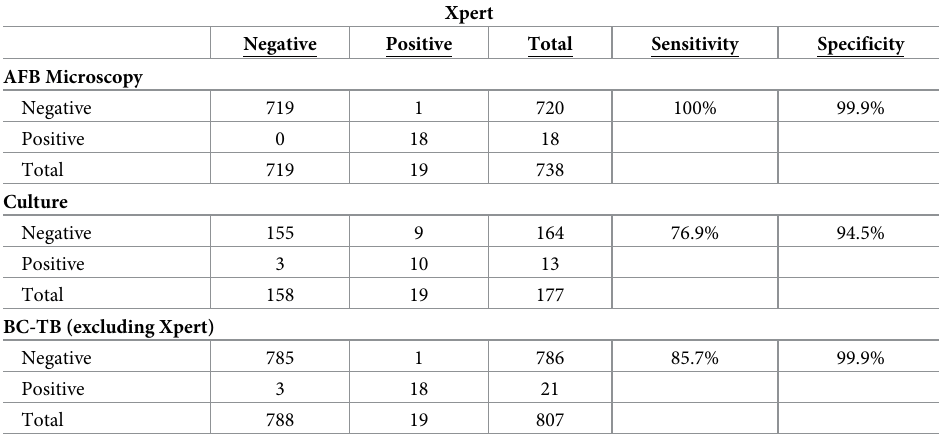
Table 4. Sensitivity and specificity of Xpert for MTB